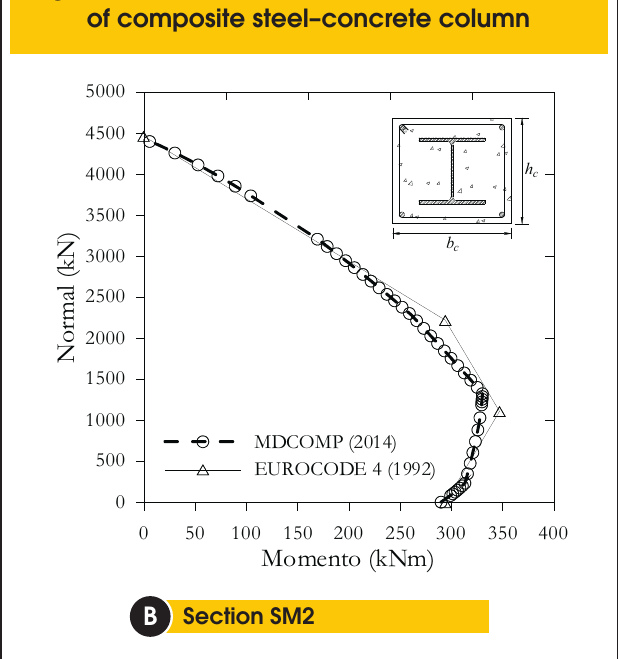
Figure 6b – Interaction curve of cross–sections of composite steel–concrete column